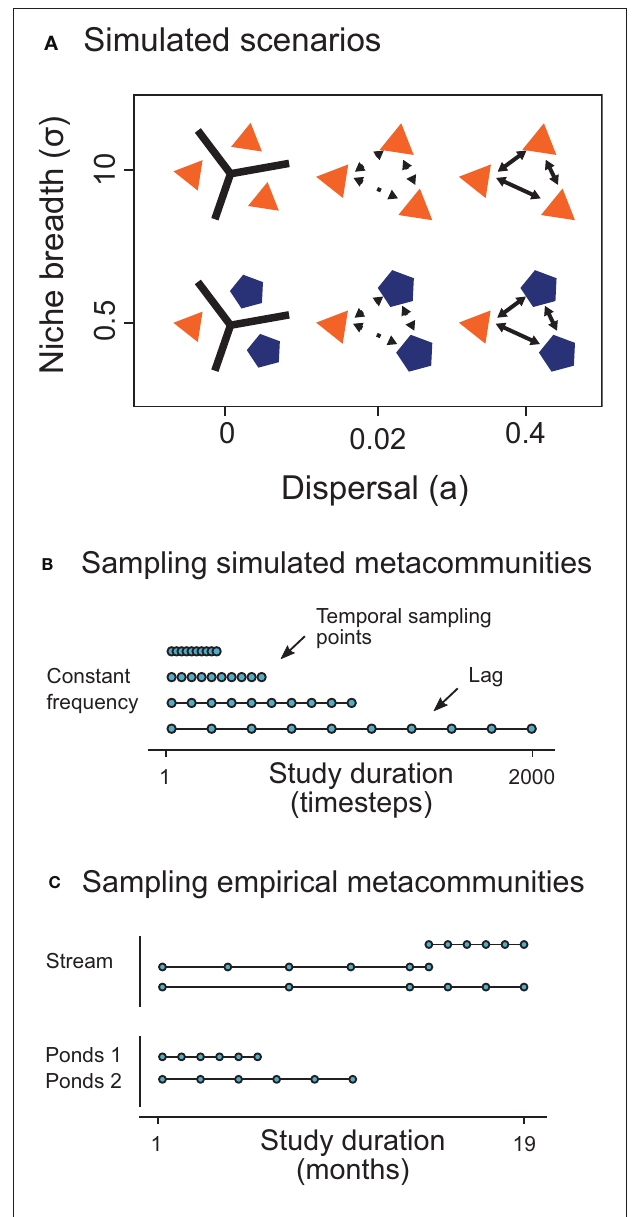
FIGURE 2 | Summary of the simulated scenarios across niche breadth (i.e., selection; σ ) and dispersal rate ( a ) gradients (A) and a summary of the temporal sampling procedure in simulated (B) and empirical (C) metacommunities. In the conceptual models, polygons, and colors represent localities with different suitable conditions for an hypothetical species depending on its niche. The lines and arrows between the polygons show the connectivity among